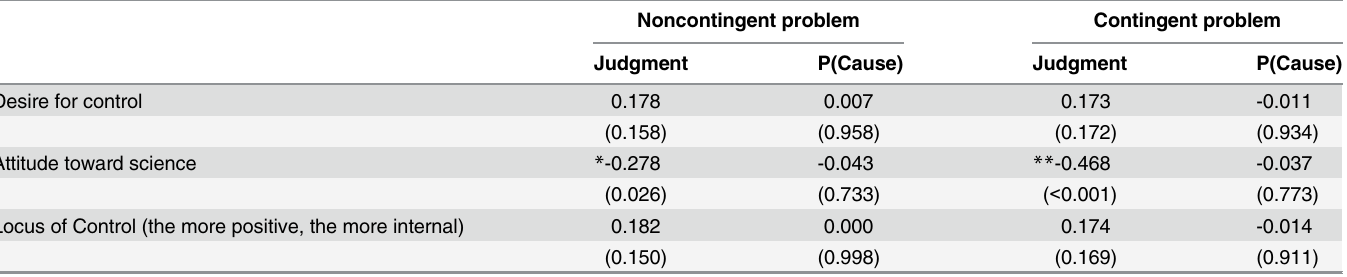
Table 2. Observed correlations between the variables assessed in the two contingency learning problems (columns) and the three exploratory questionnaires (rows). Noncontingent problem Contingent problem Judgment P(Cause) Judgment P(Cause) Desire for